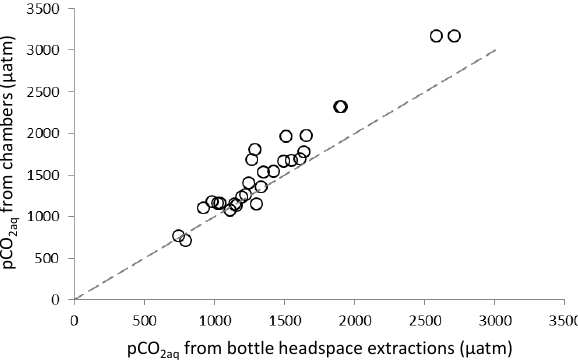
Figure 6. Theoretical equilibration time to within 90% (TET 90 ) of the true p CO 2aq after deploying the described chambers (solid lines) at different piston velocities ( k) , a temperature of 20 ◦ C, and a p CO 2aq of 2000µatm (gray) or 8000µatm (black). The dashed lines show TET 90 for chambers with a twice higher area-to-volume ratio compared to the chambers we used. Another way to speed up equilibration time is by mixing the water below the chambers (see